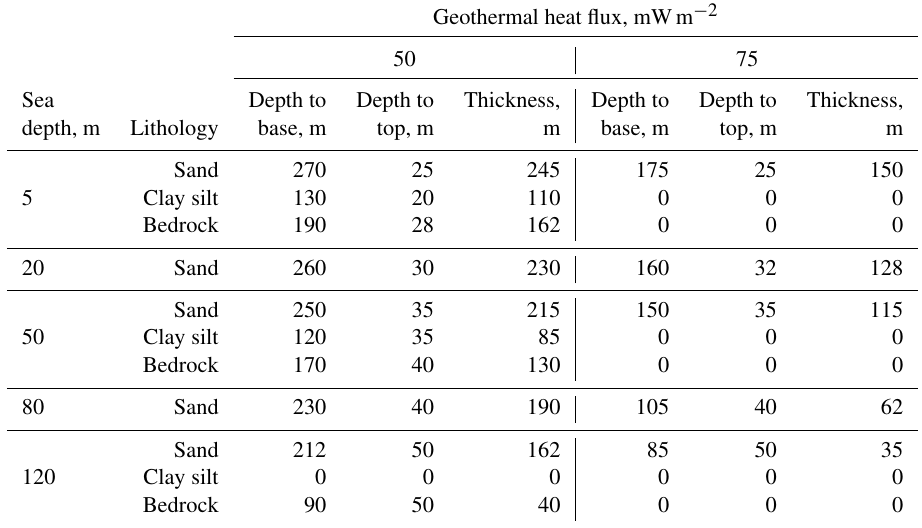
Table 5. Modeling results for depths to permafrost top and base and permafrost thickness for uniform lithology, NE